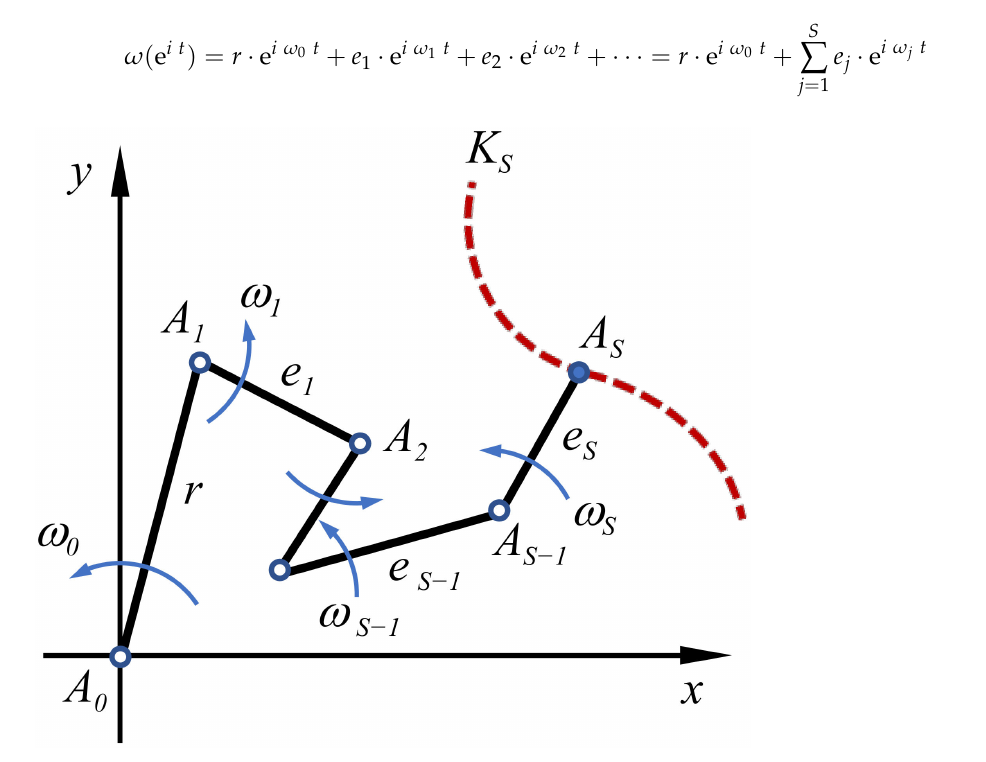
Figure 1. Definition of the higher trochoid